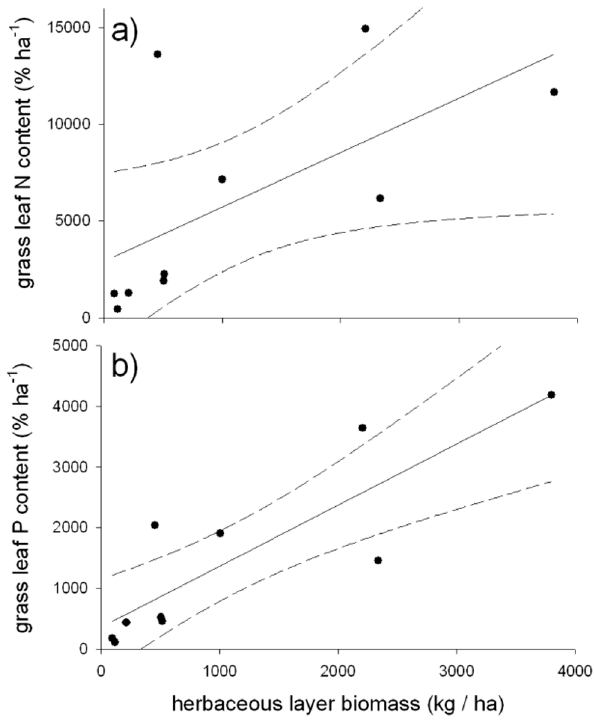
Figure 5. Regression line and 95% CI (solid and dashed lines, respectively) of grass leaf N (A) and P (B) contents against overall herbaceous layer standing biomass. Filled circles repre- sent values for sub- and outside tree canopy herbaceous biomass averaged for each site.